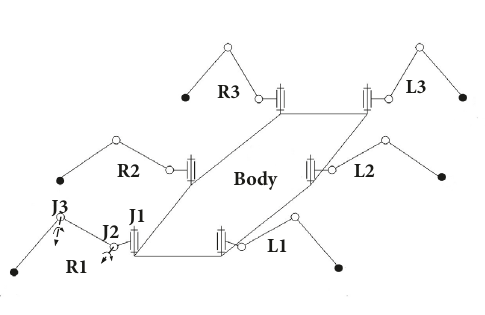
Figure 18: Structure diagram of a hexapod robot.